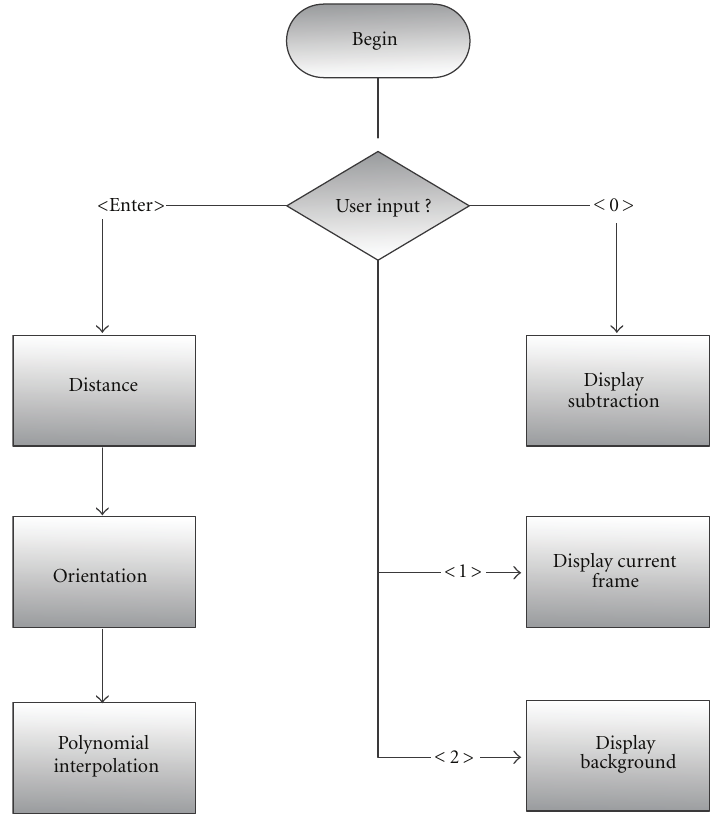
Figure 11: Flowchart of the NiosII coprocessor.